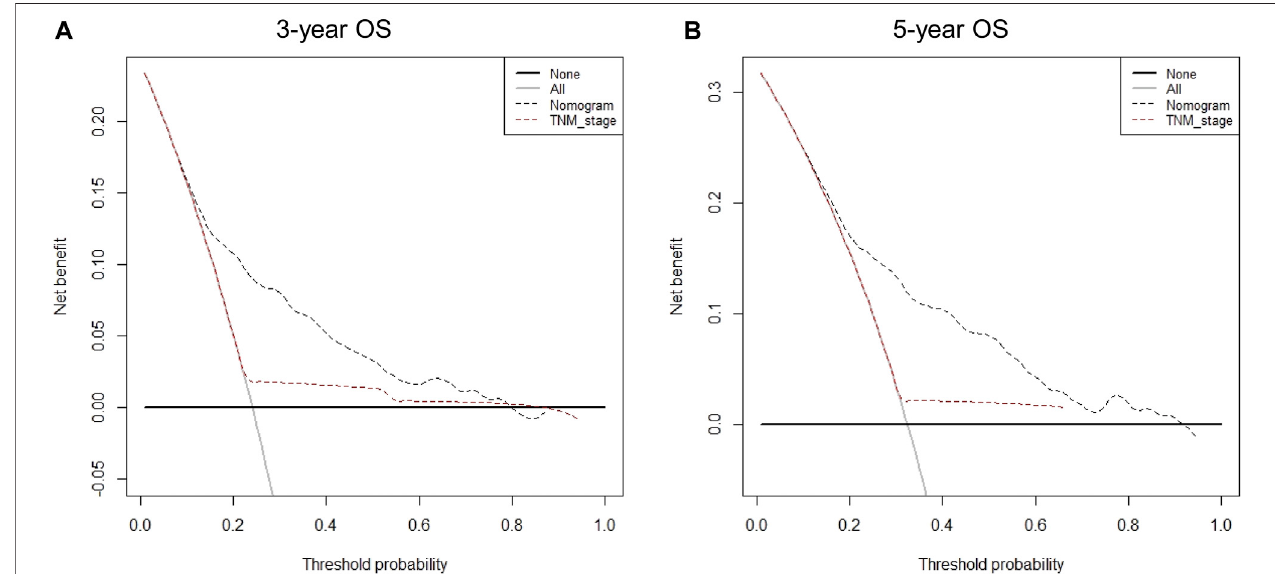
FIGURE 5 | Decision curve analysis for different predictive models: (A) Nomogram were compared to the 8th AJCC TNM stage in terms of 3-year OS; (B) Nomogram were compared to the 8th AJCC TNM stage in terms of 5-year OS.